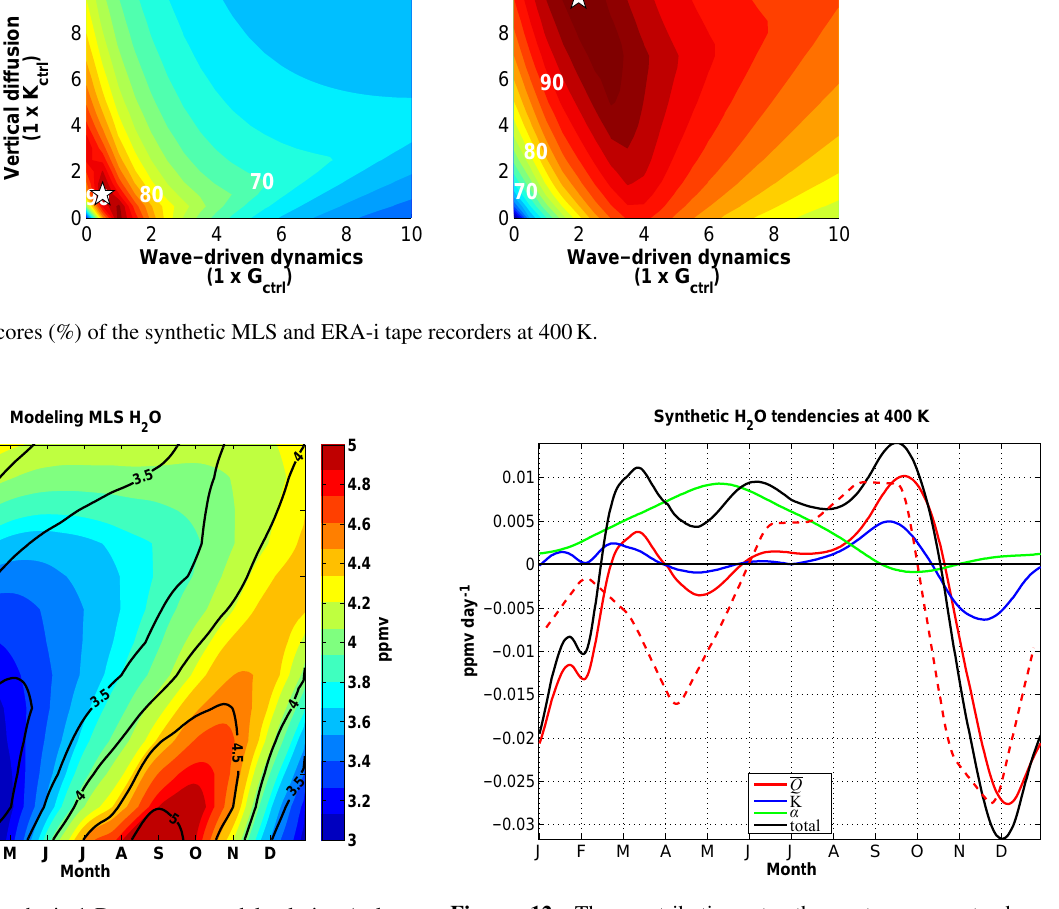
Figure 11. The best synthetic 1-D transport model solution (color shading; a = b = c = 1; corresponding to white star in left panel of Fig. 10) of the MLS water vapor tape recorder signal (black con- tours for reference) in isentropic coordinates.